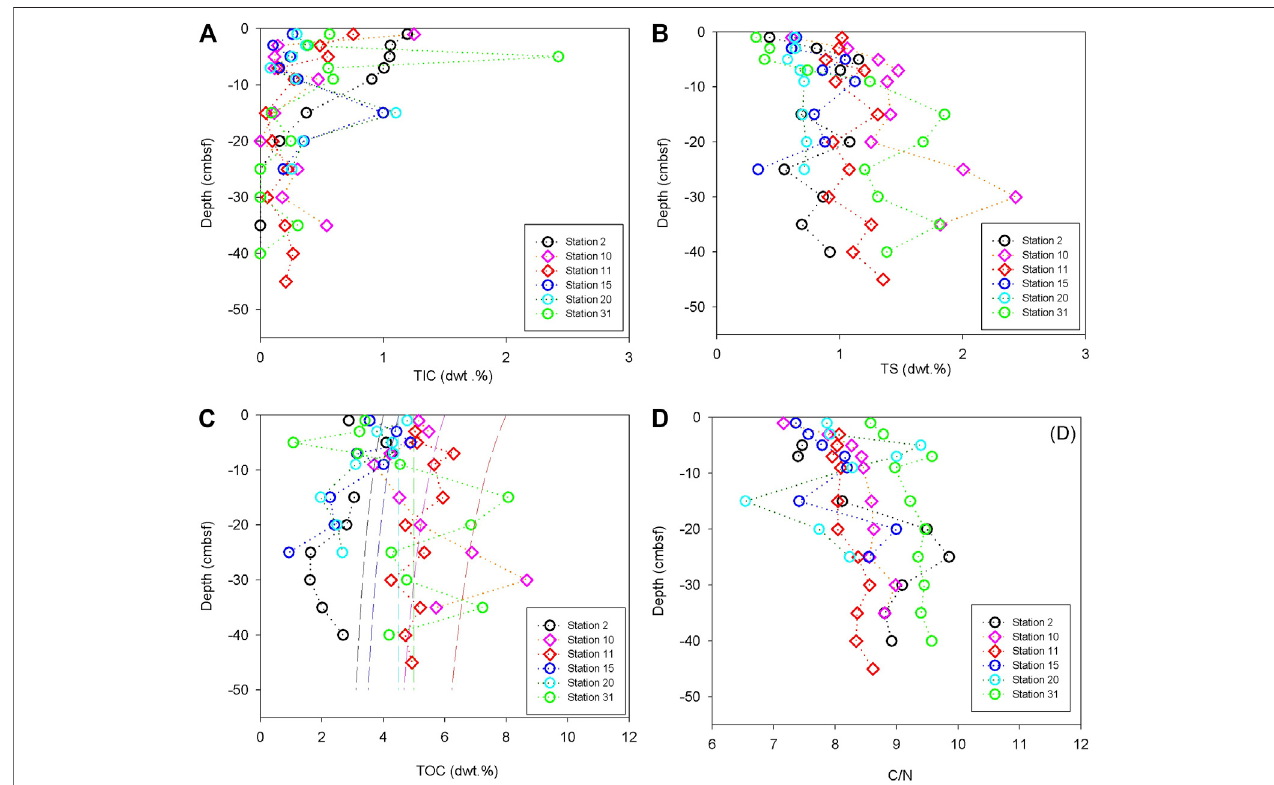
FIGURE 7 | Vertical pro fi les of the bulk geochemical parameters TIC (A) , TS (B) , TOC (C) , and C/N (D) ratios in sediments cores from the WB. The dashed lines in panel C (TOC) display the results from the diagenesis transport model (see discussion).